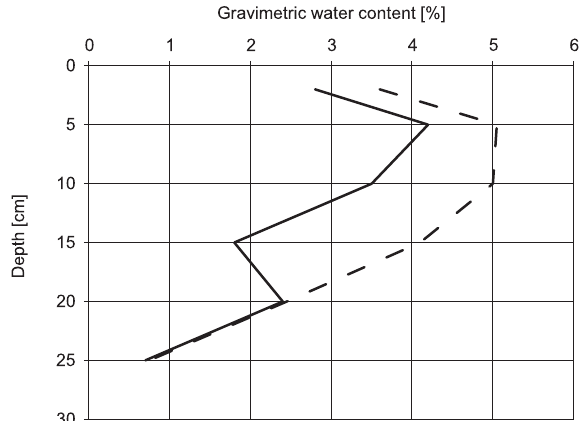
Fig. 4. The sand gravimetric water content changes with depth in deposits at 1200 o’clock, on the example of the western horn of the dune near Laâyoune (φ 27°21'50.8" N and λ 13°07'44.1" W). Dashed line – 04.03.2010, solid line